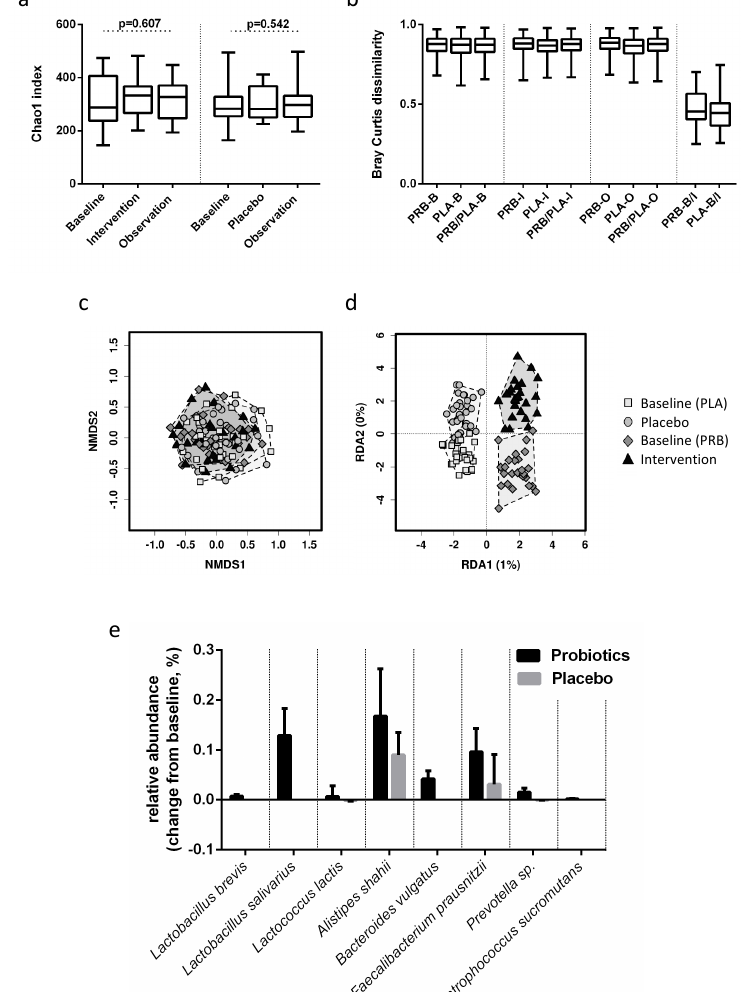
Figure 2. Probiotic modulation of the microbiome in compensated cirrhosis. ( a ) Chao1 index for probiotic- and placebo-treated patients before and after intervention and after follow up. ( b ) Bray Curtis dissimilarities within and between probiotic-treated (PRB) and placebo-treated (PLA) patients at baseline (B), after intervention (I) and at follow up (O). ( c ) Non-metric multidimensional scaling plot of probiotic (PRB)- and placebo (PLA)- treated patients before (Baseline) and after intervention (Intervention/Placebo). ( d ) Redundancy analysis for intervention and time point. ( e ) Differentially abundant OTUs at the end of intervention presented as changes from baseline in relative abundance for probiotic and placebo-treated patients. Bars represent mean and standard error.